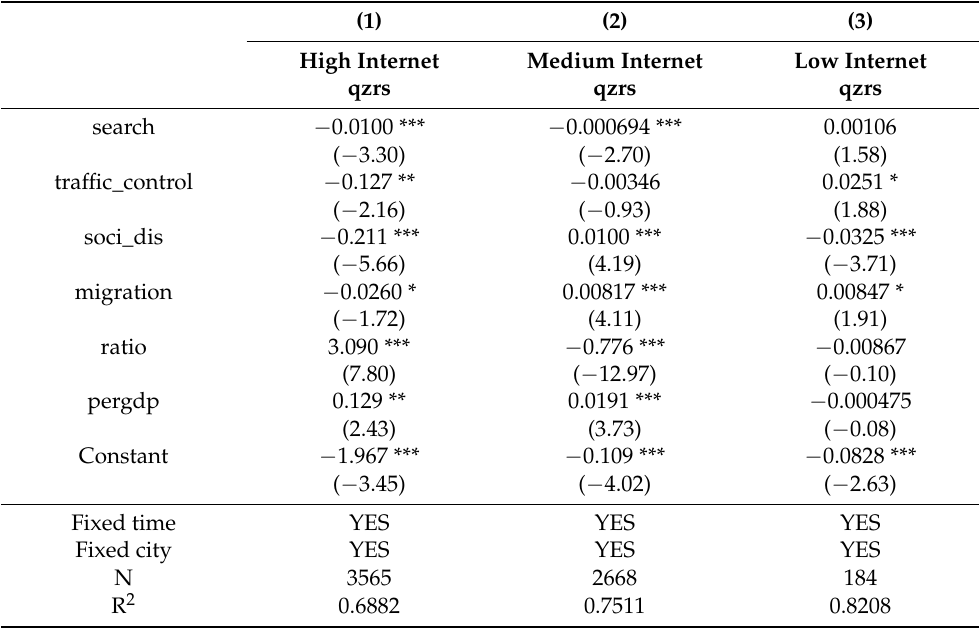
Table 8. Heterogeneity test results of Internet